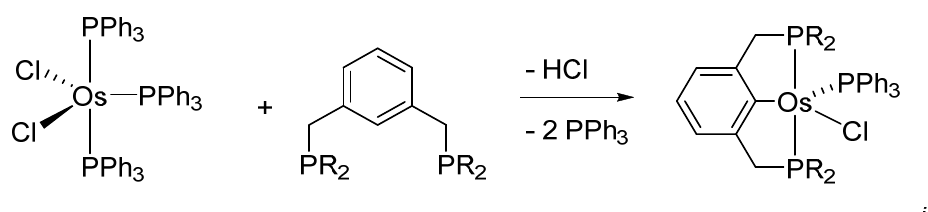
Figure 6. Synthesis of P~C~P pincer complex from 1,3-(R 2 PCH 2 ) 2 C 6 H 4 . {1,3,5-(CH 3 ) 3 -2,6-( i Pr 2 -PCH 2 ) 2 C 6